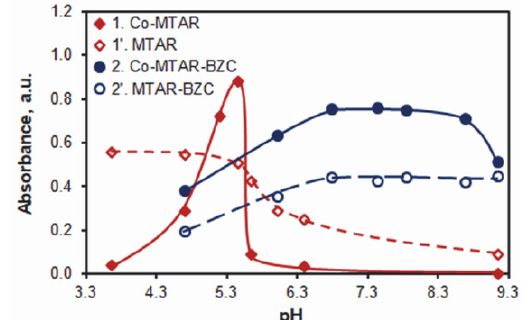
Figure 3. Absorbance of the Co-MTAR (1) and Co-MTAR-BZC (2) complexes and corresponding blanks (1’ and 2’) vs pH of the aque- ous phase. Co = 4 × 10 −5 mol dm −3 (1, 2); c MTAR = 4 × 10 −4 mol dm −3 (1, 1’, 2, 2’); c BZC = 1 × 10 −3 mol dm −3 (2, 2’); λ = 509 nm (1,1’) or 550 nm (2,2’); t